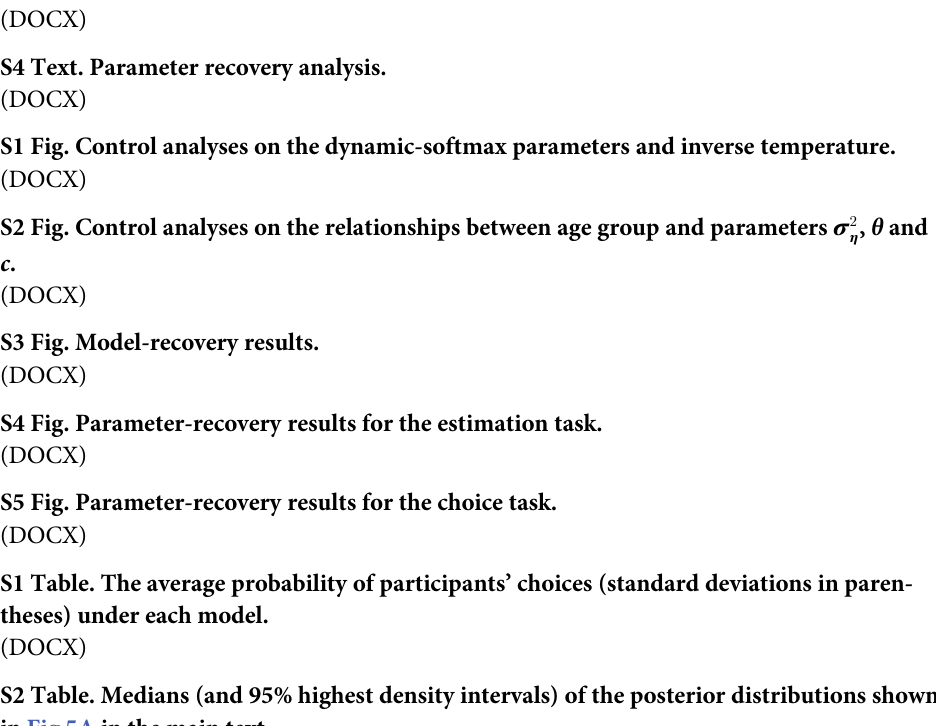
S1 Table. The average probability of participants’ choices (standard deviations in paren- theses) under each model. S2 Table. Medians (and 95% highest density intervals) of the posterior distributions shown in Fig 5A in the main text. S3 Table. Prior distributions for the simulation hyperparameters used in the model-recov- ery